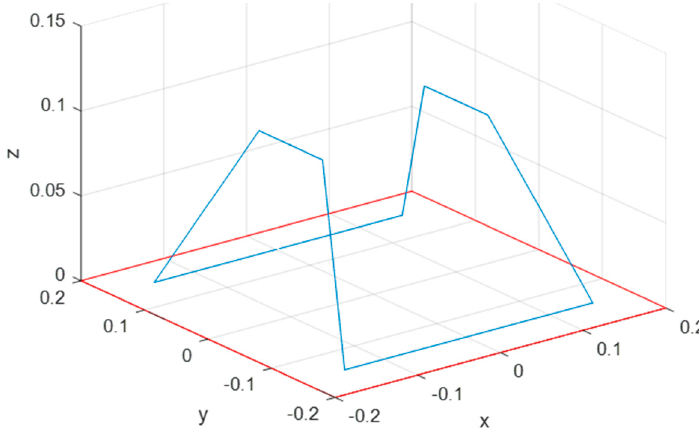
Figure 6. WPT system with primary single coil of square shape ( red ) and 3D secondary coil ( blue ).